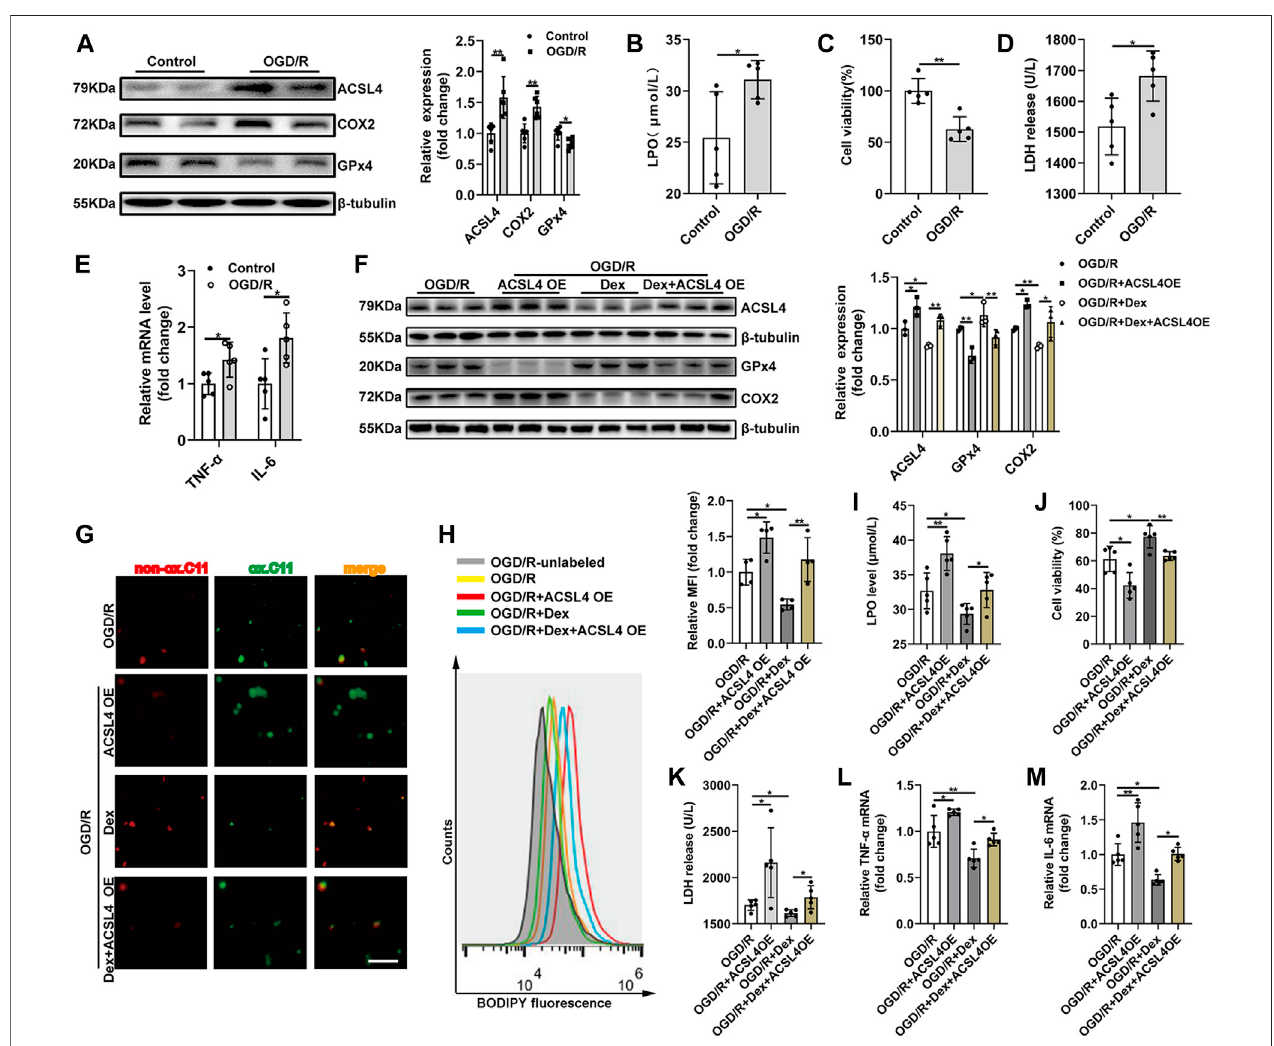
FIGURE5| ACSL4OverexpressionAbolishesDex-mediatedProtectiveEffectsonOGD/RInducedHEK293TCellsFerroptosisandIn fl ammation. (A) Westernblot was used to detect the ACSL4, COX2 and GPx4 protein expression in the HEK293T cell. The protein intensity was analyzed by using ImageJ ( n = 6). (B) Cell lipid peroxidationweredetectedbyLPOassayKits( n =5). (C) CellsurvivalwasdeterminedbyCCK-8kitafterOGD/R( n =5). (D) ThelevelofLDHafterOGD/R( n =5). (E) The qRT-PCR analysis of IL-6 mRNA ( n = 5) and TNF- α mRNA ( n = 5). (F) The expression of ACSL4, Gpx4, and COX2 were detected by western blot ( n = 3). (G) Cell survival was determined by CCK-8 kit ( n = 5). (H) Cell lipid peroxidation were detected by BODIPY 581/591 C11 staining use fl uorescence microscopy (original magni fi cation,×100,scalebar=50 μ m). (I) RepresentativehistogramsandMean fl uorescenceintensity(MFI)ofBODIPYoxidationinHEK293Tcells( n =4). (J)